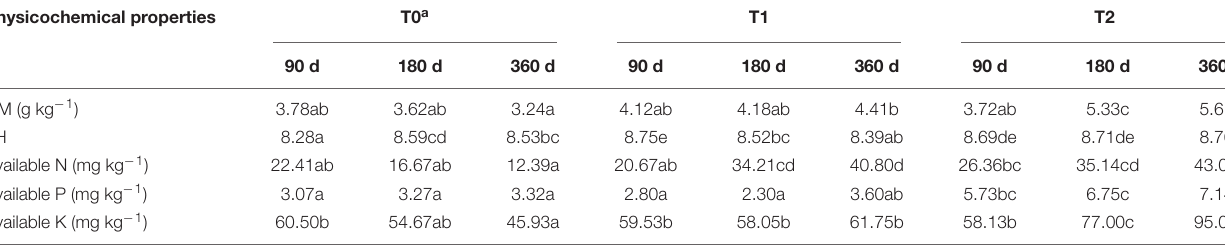
TABLE 1 | The physicochemical properties of the iron tailing sand. Physicochemical properties